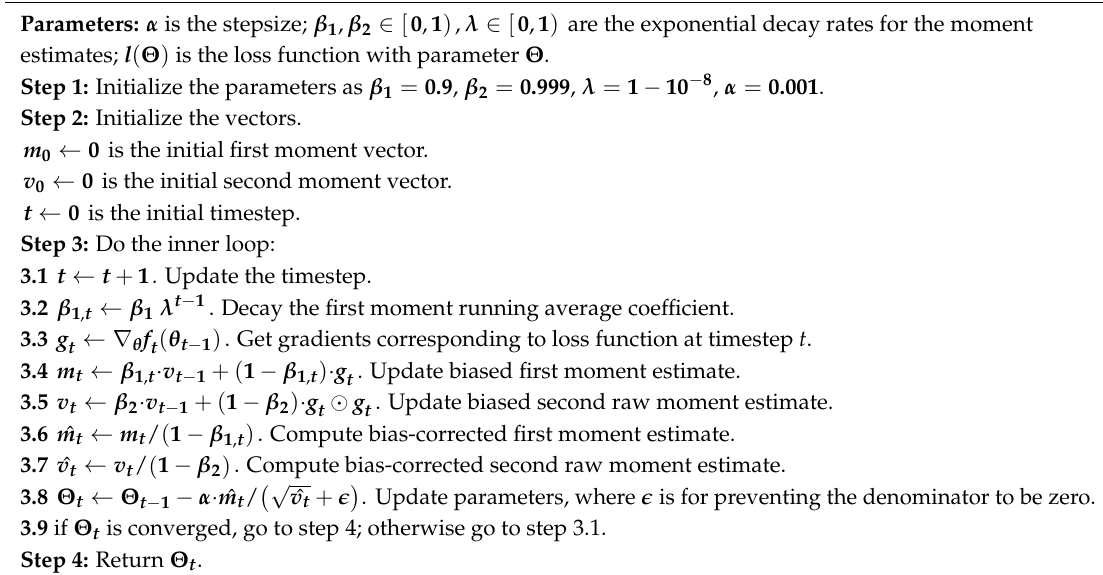
Algorithm 2. Adam Method for